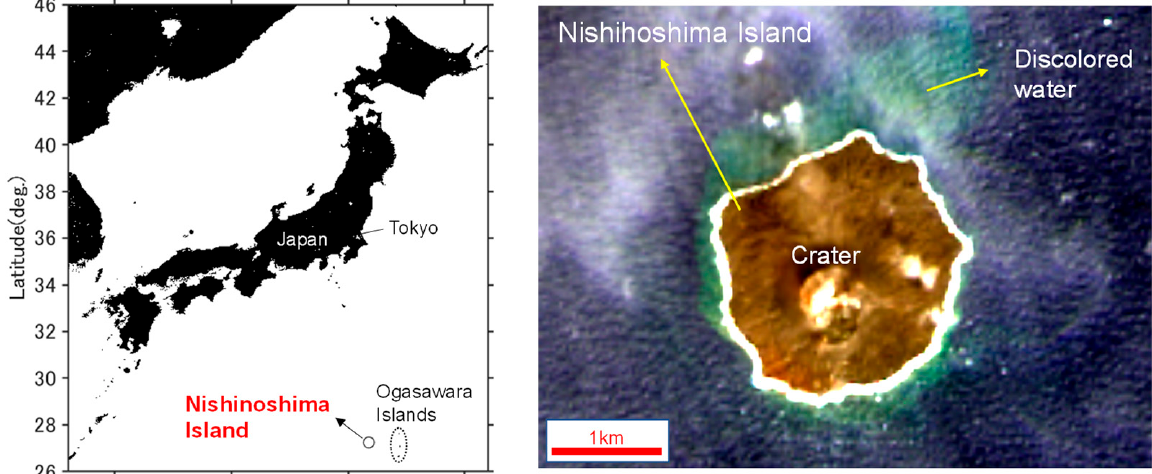
Figure 1. Map of Nishinoshima Island ( left ) and Landsat-8 Operational Land Imager (OLI) image of the island taken on 5 September 2020 ( right ).